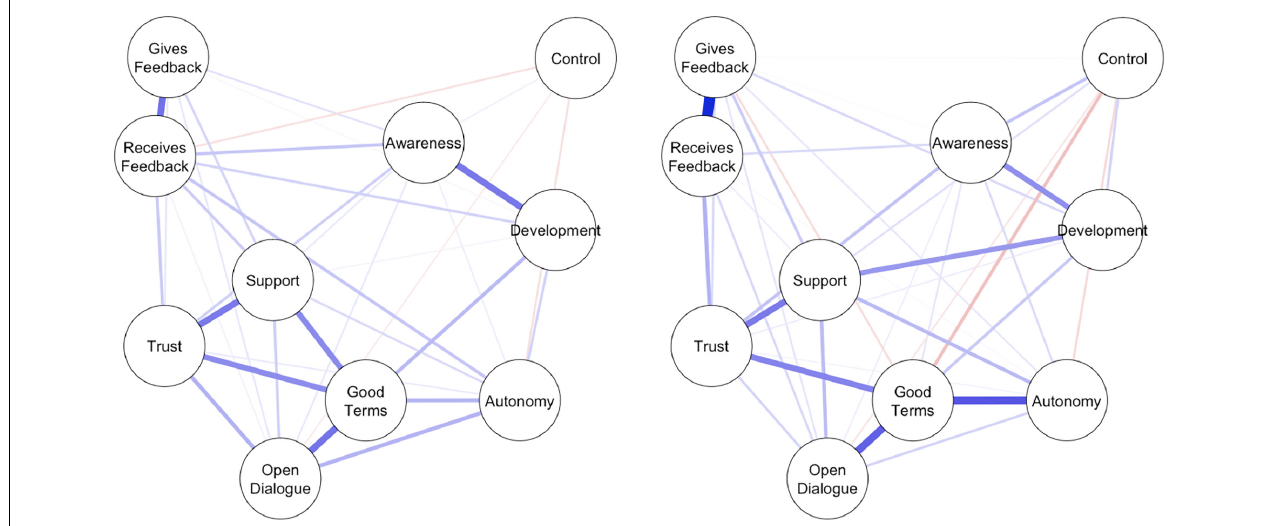
FIGURE 3 | Survey networks of leadership attitudes of both non-supervisors (Left) and supervisors (Right) . Blue edges represent positive relationships, red edges represent negative relationships. Thicker edges represent stronger